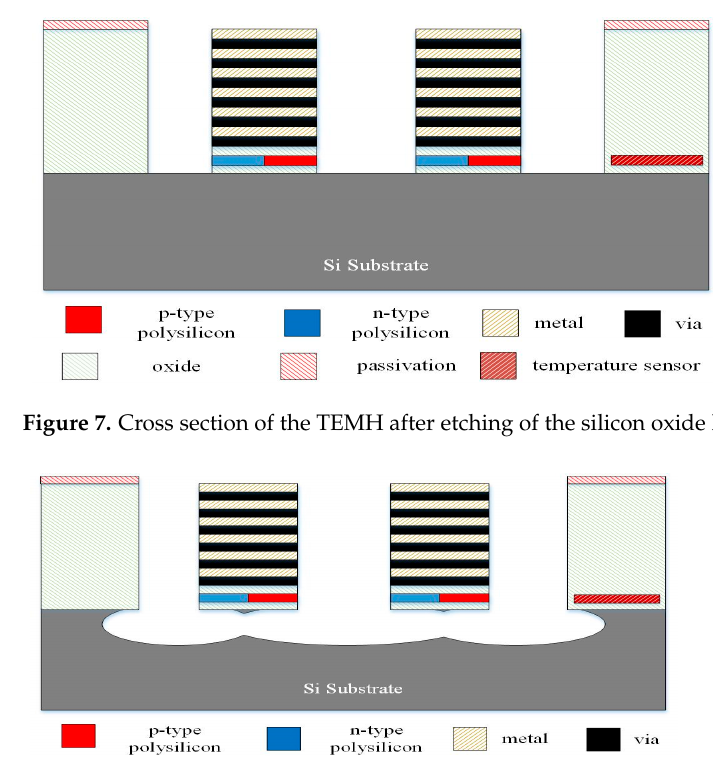
Figure 6. Cross section of the TEMH after the CMOS process.